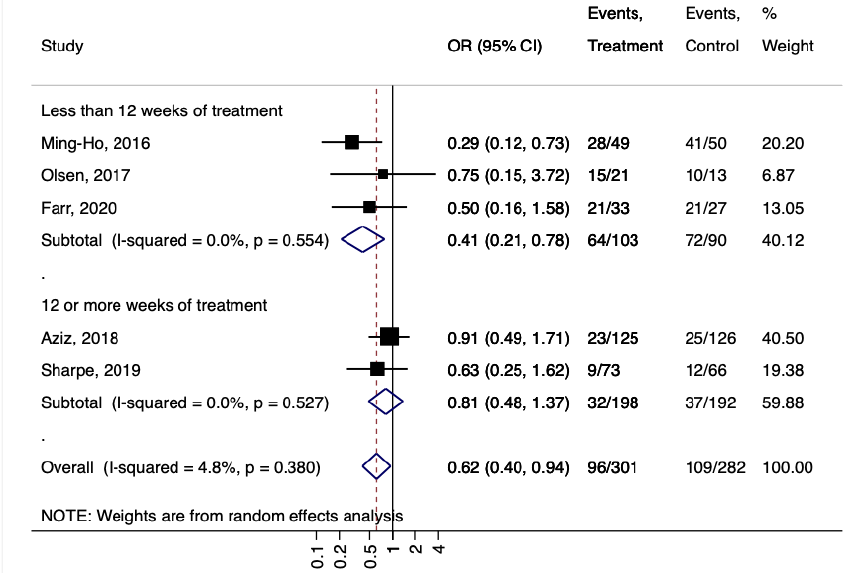
Figure 6. Forest plot for the GBS colonization according to the duration of treatment with probiotics (less than 12 weeks or more than 12 weeks). Ming-Ho, 2016 [32], Olsen, 2017 [33], Farr, 2020 [36], Aziz, 2018 [34], Sharpe, 2019 [35].